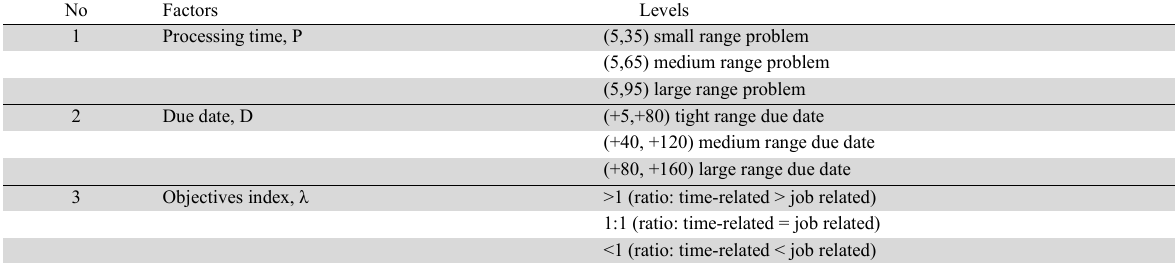
Factor levels for the experiments